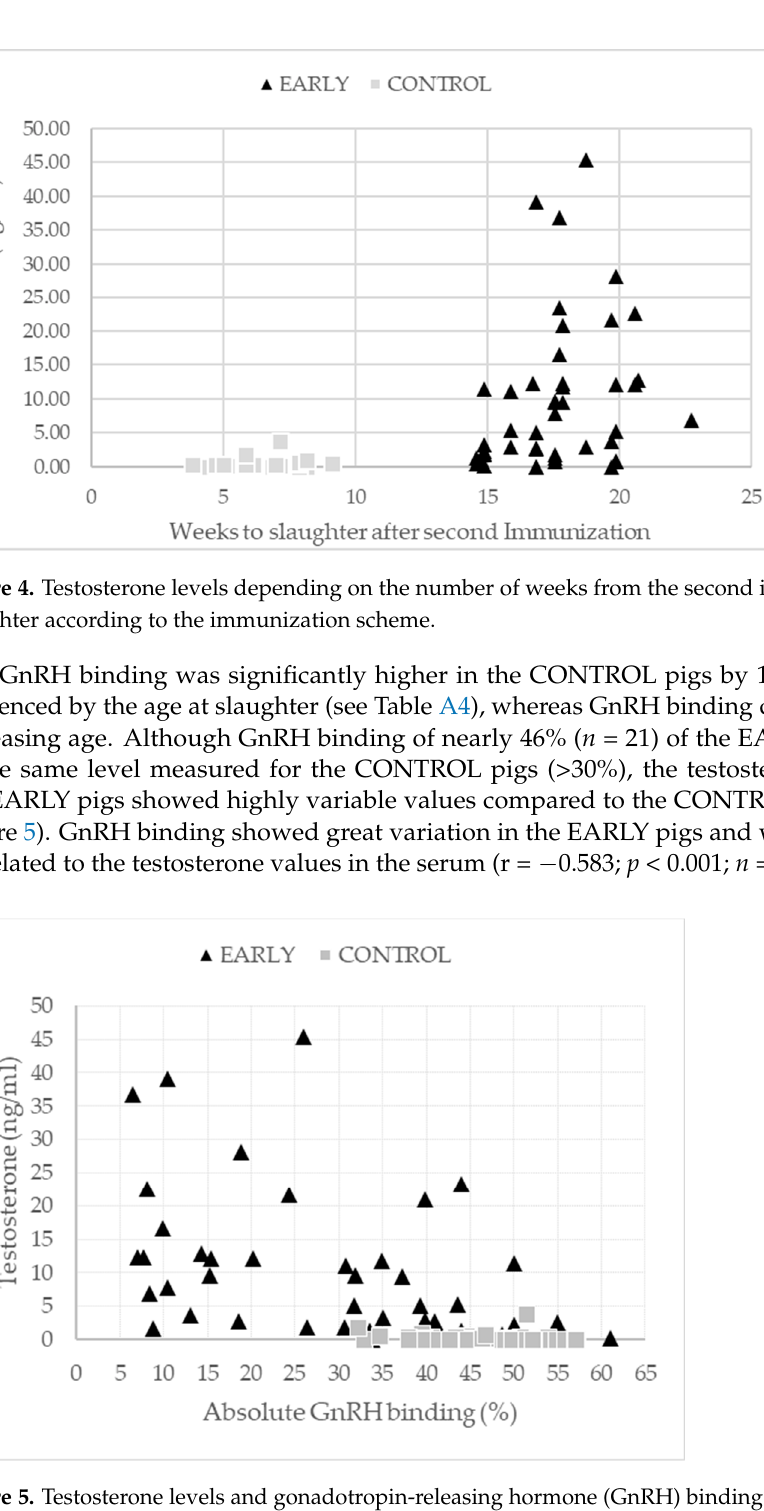
8 of 17 Figure 3. Atrophication classification according to immunization scheme. Testosterone levels and GnRH binding differed significantly between the trial groups and a significant interaction of immunization scheme and trial run was found in the case of testosterone. Age at slaughter had no significant effect on testosterone values, whereas GnRH binding decreased with increasing age at slaughter. Regardless of the lower testos-